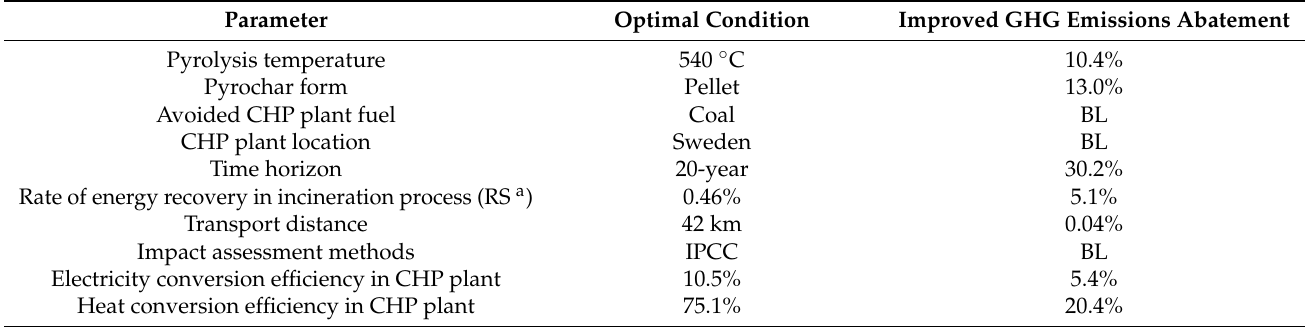
Table 2. The optimal condition for each parameter considered in the sensitivity analysis (See SI for the results of the last six